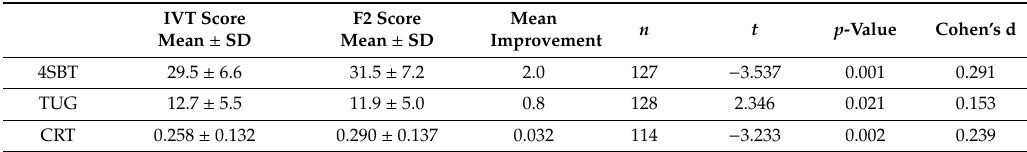
Table 2. Mean Changes in Physical Performance Measures.